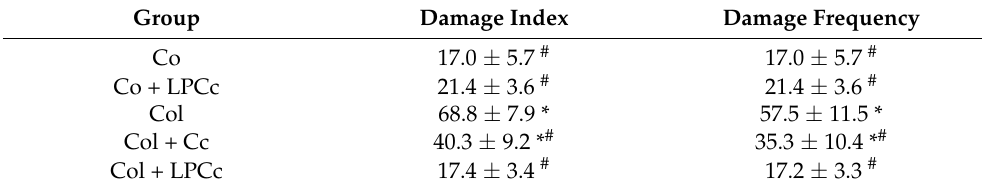
Table 4. Comet assay in peripheral blood of the studied groups. Co: control; Co + LPCc: control + LPC cookie; Col: colitis; Col + Cc: colitis + control cookie; Col + LPCc: colitis + LPC cookie. * p < 0.001 when compared to control and # p < 0.001 when compared to